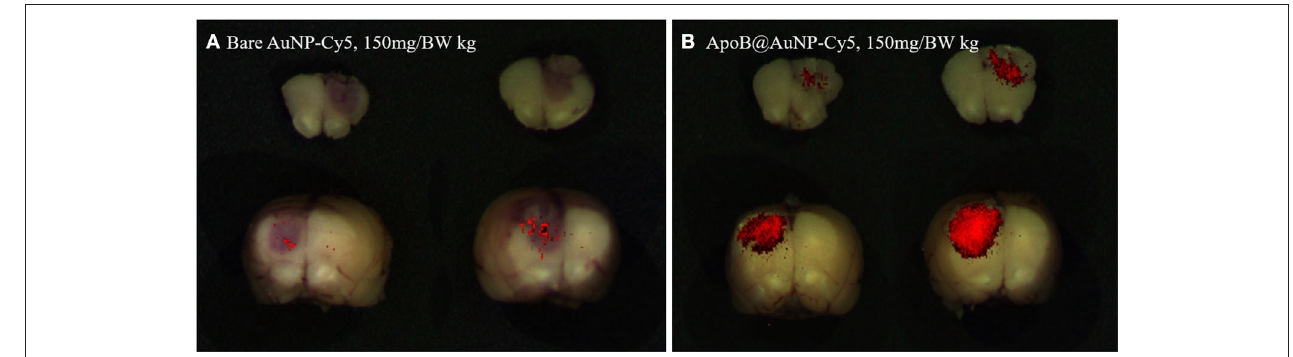
FIGURE 3 | Fluorescence imaging of AuNP-Cy5 (A) and ApoB@AuNP-Cy5 (B) that were taken up in glioma target at 24h after IV injection of 150 mg/BW kg in glioma model. Much larger targeted-NP was taken up in the glioma mass compared with bare NP.